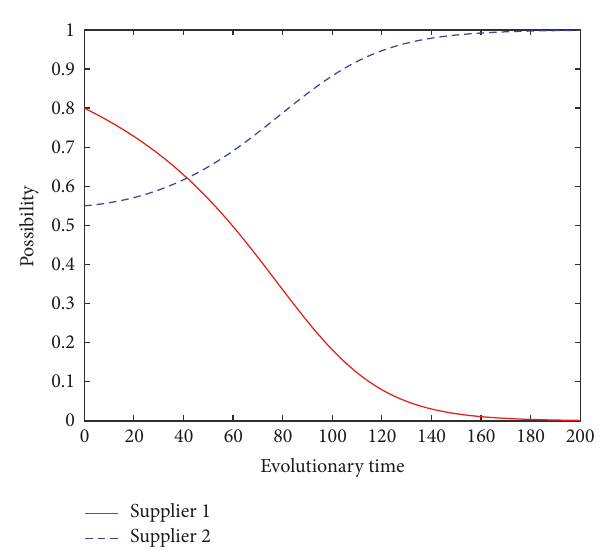
Figure 3: The evolutionary process of product 2.